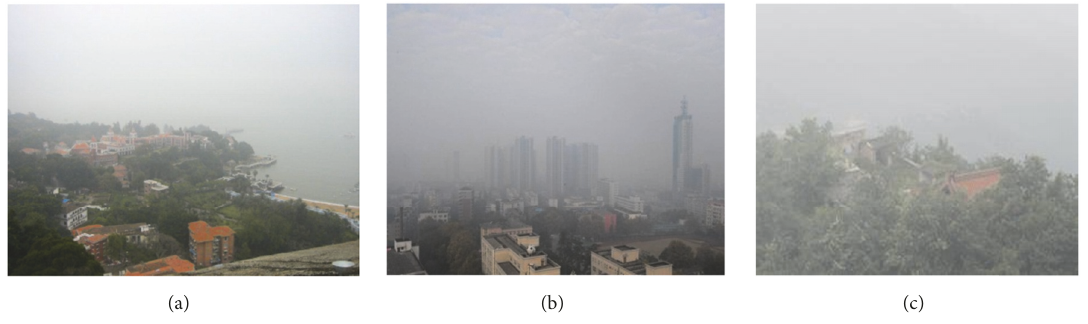
Figure 3: Original images with obvious light color areas.